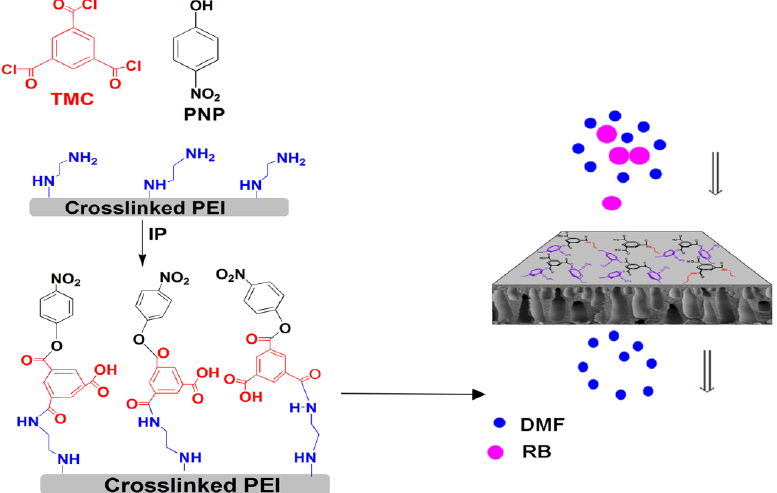
Figure 4. The deconvolution C1s, N1s, and O1s XPS spectra of NF-C ( a – c ) and NF-1OL ( d – f ) membranes.